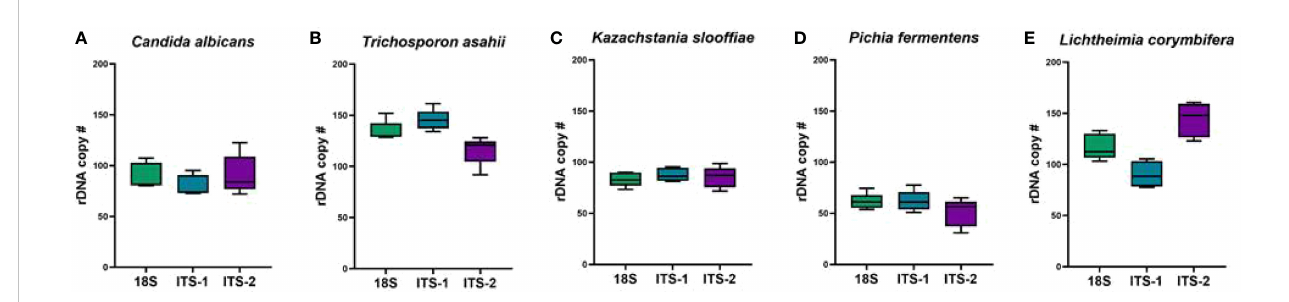
FIGURE 7 Estimated rDNA copy numbers. Primers targeting 18S, ITS1, and ITS2 were analyzed for copy number in each of the fi ve fungal species utilized in the mock community. (A) Candida albicans , (B) Trichosporon asahii , (C) Kazachstania sloof fi ae , (D) Pichia fermentans and (E) Lichtheimia corymbifera